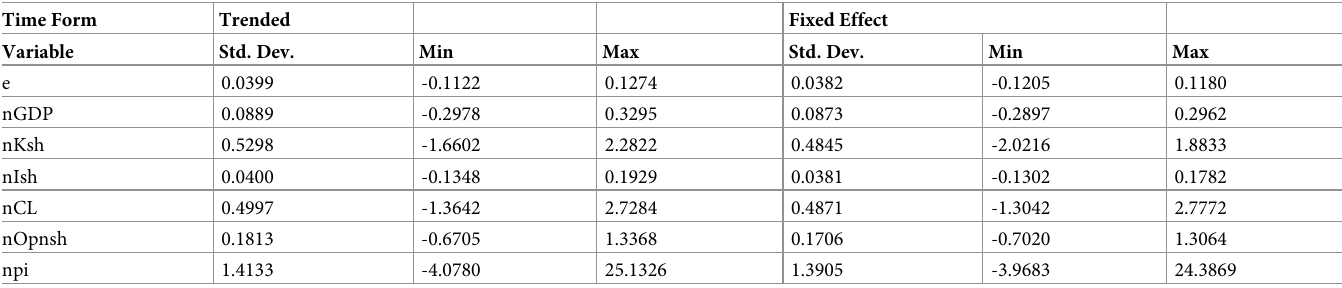
Table 17. Variable statistics for value assignment.